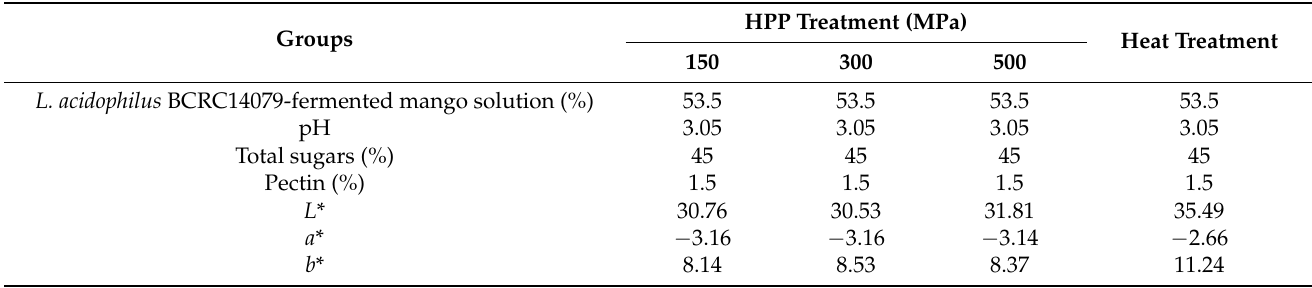
Table 2. The parameters of L. acidophilus BCRC14079-fermented mango jam by HPP treatment. L* : lightness component (range, 0–100); a* : chromatic component (redness/greenness [+/ − ]); b* : chromatic component (yellowness/blueness [+/ − ]). HPP Treatment (MPa) Groups Heat Treatment 150 300